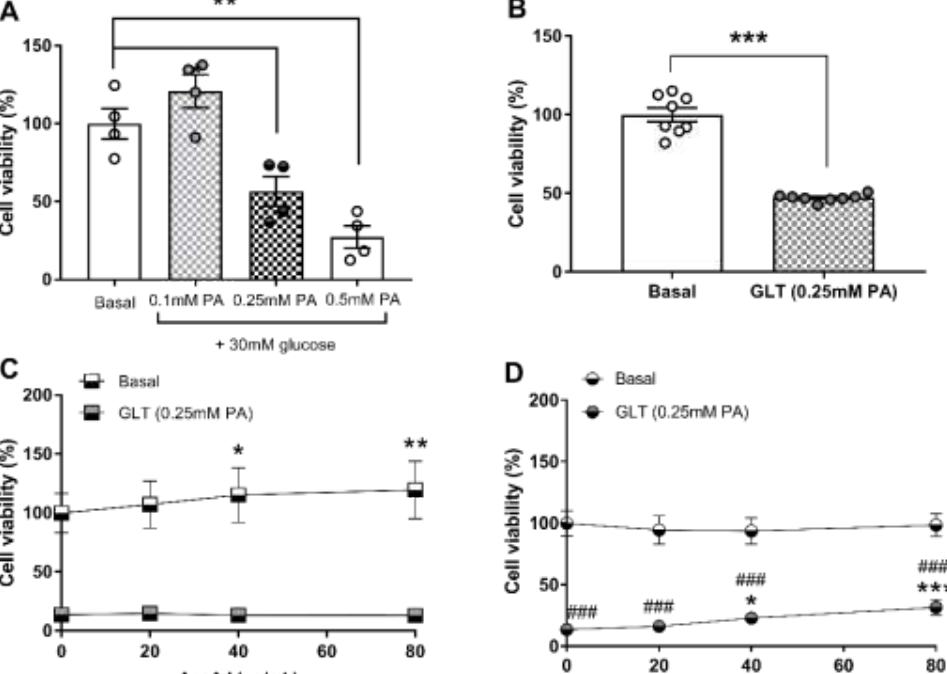
Figure 2. The impact of palmitic acid (PA; 0.1 mM to 0.5 mM), in the presence of 30 mM glucose (GLT challenge), on the viability of 1.1B4 cells, as judged by conversion of MTT to formazan in four independent experiments (mean ± SEM), normalised to the basal condition, is shown in ( A ). Data were analysed by one-way ANOVA with post hoc tests compared to the basal group * p < 0.05, ** p < 0.01. The effect of 0.25 mM PA, under the same conditions, measured by conversion of resazurin to fluorescent resorufin, is shown in ( B ); values are the mean ± S.D. of eight independent replicates in a single experiment; the data were analysed by Students’ t -test; *** p < 0.001. The impact of apoA-I (0–80 μg mL −1 ) on the viability of 1.1B4 cells under GLT challenge is shown in ( C ) (mean ± SEM; n = 3); the data were analysed by two-way ANOVA with post hoc test (Dunnett’s) compared to the basal group in the absence of apoA-I * p < 0.05, *** p < 0.001. The effect of HDL (0–80 μg mL −1 ) under the same conditions is shown in ( D ) (mean ± SEM; n = 3). The data were analysed by two-way ANOVA with post hoc test (Dunnett’s) compared to the basal group in the absence of HDL. ### p < 0.001 compared with the GLT challenge alone, or *** p < 0.001 compared with the GLT challenge alone.